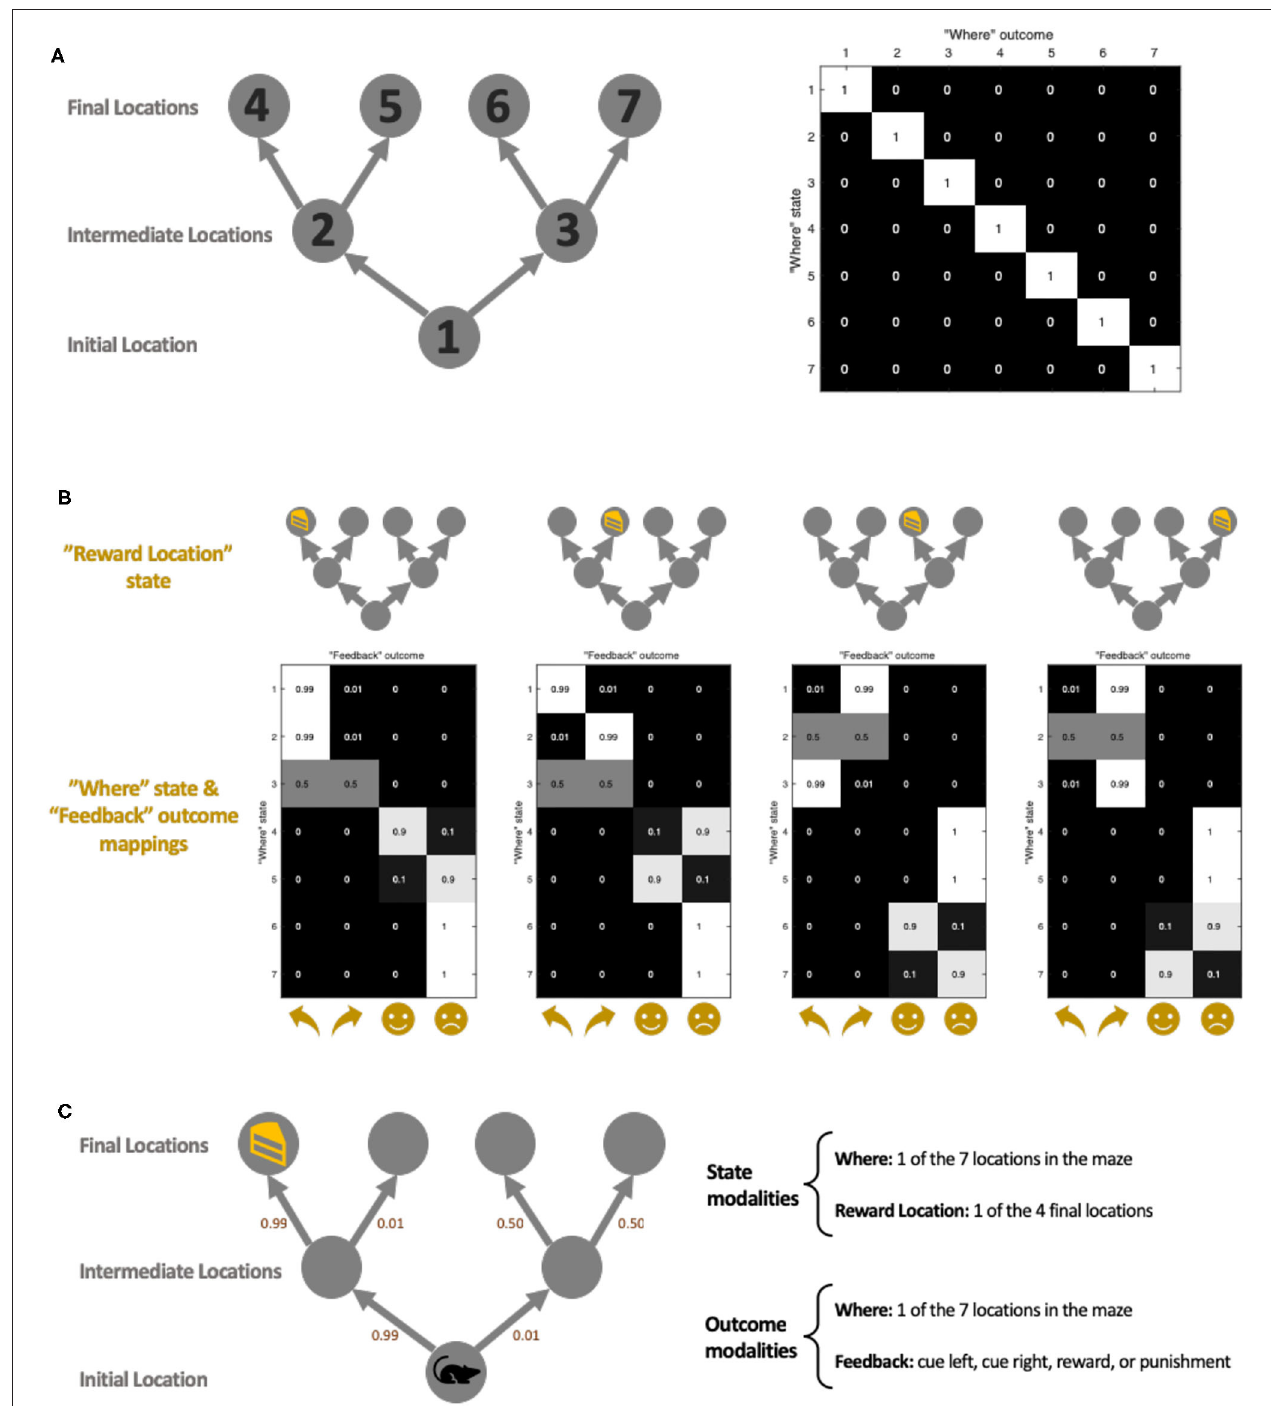
FIGURE 2 | Simulation maze set-up. (A) The maze location set-up. There are a total of 7 locations in the maze, each with their corresponding indexes (left diagram). The state-outcome mapping (A matrix) between “Where” (i.e., agent’s current location) state and outcome is an identity matrix (right figure), meaning they